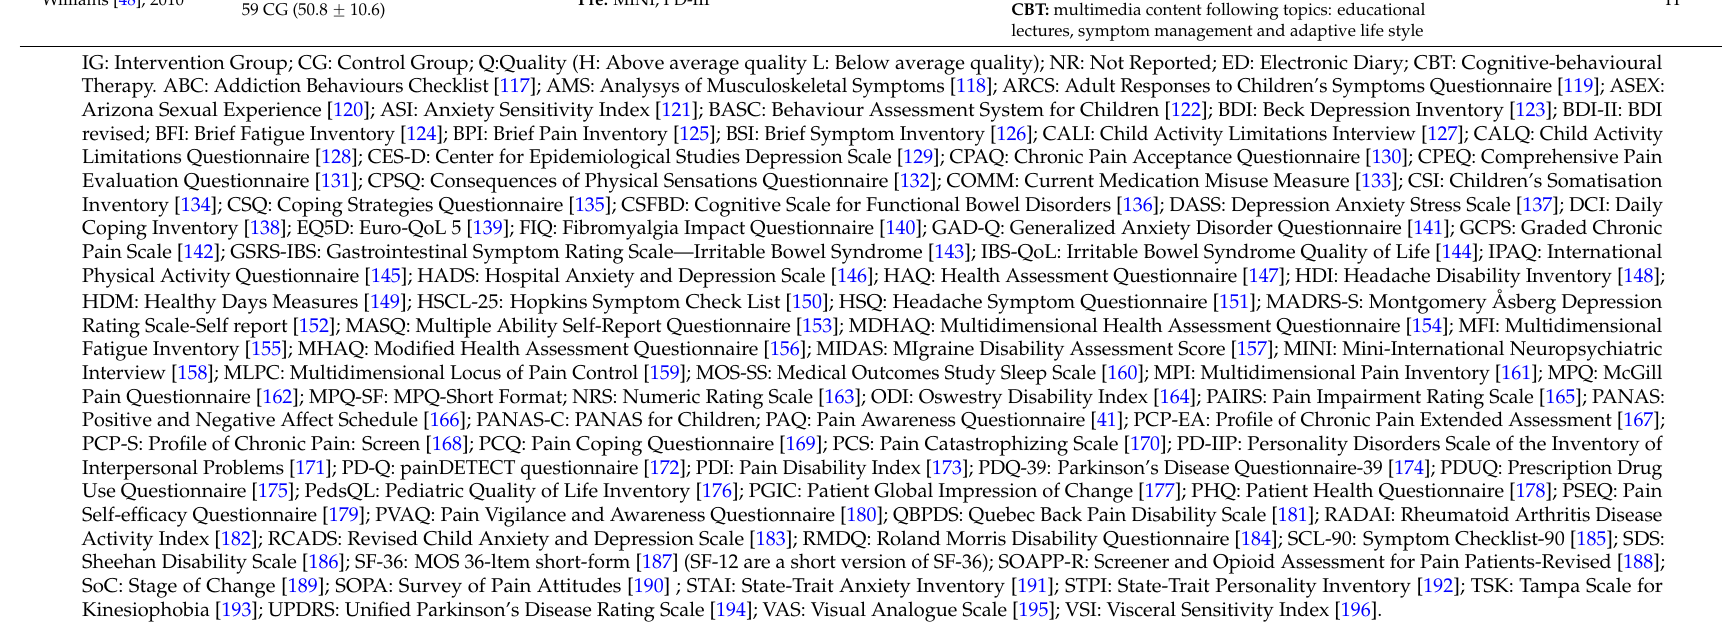
for training relaxation. Post: Pain intensity